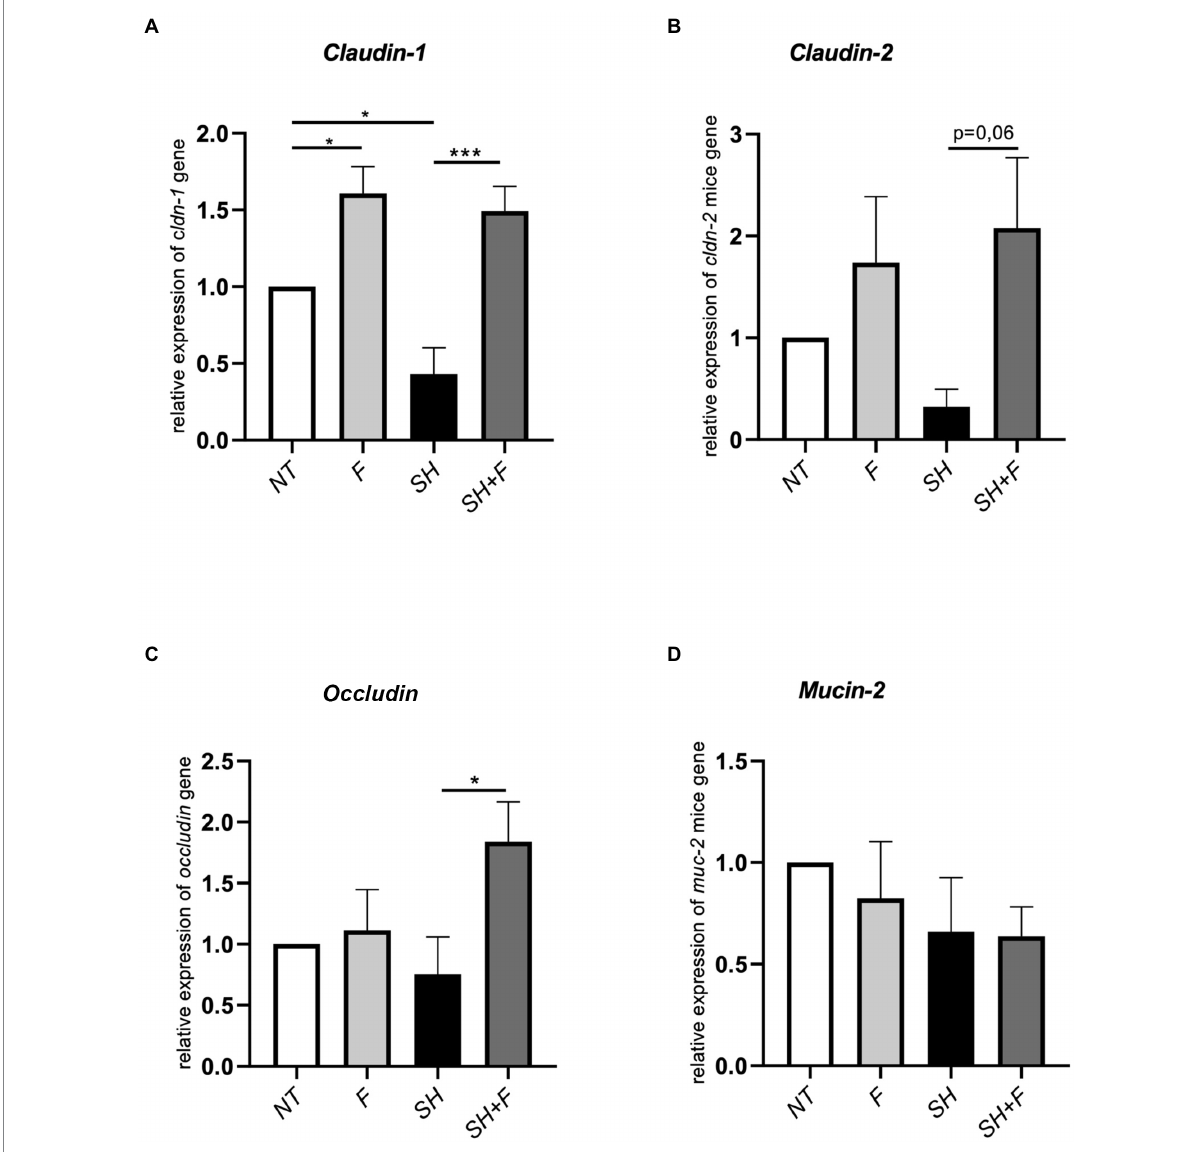
FIGURE 5 Bioactive fractions improved tight junction genes expression in mice colon. Relative expression of (A) claudin-1 ( cldn-1 ), (B) claudin-2 ( cldn-2 ), (C) occludin , and (D) mucin-2 ( muc-2 ) in colon tissue from mice treated with bioactive fractions (F) , mice infected with S . Heidelberg (SH) and mice receiving both S . Heidelberg and bioactive fractions (SH + F). Results are normalized to control mice without fraction and without Salmonella (NT). All genes were reported based on the reference housekeeping gene hprt ( hypoxanthine phosphoribosyltransferase 1 ). Normality of data was verified by Shapiro test and ANOVA one way was used. All data were presented as means (SEM), n = 4–5. * p < 0.05 and *** p <